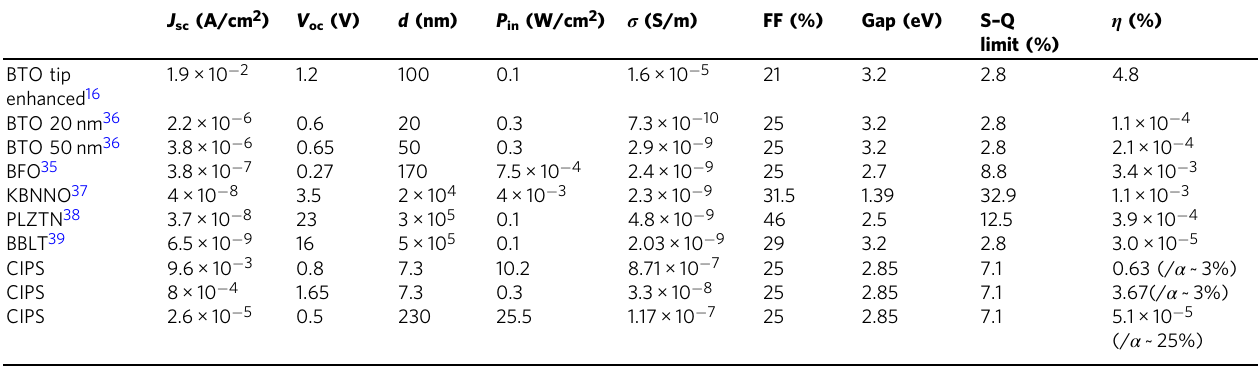
Data in the fi rst seven rows are from previous literature; the last three rows are data from our samples. The photoconductivity per power density can be obtained using σ / P in , in which the CIPS almost have the smallest conductivity per excitation density. For the power conversion ef fi ciency, the best value for thin CIPS fi lms in this study is closing to the S – Q limit when considering the absorption at 405nm (see Supplementary Note